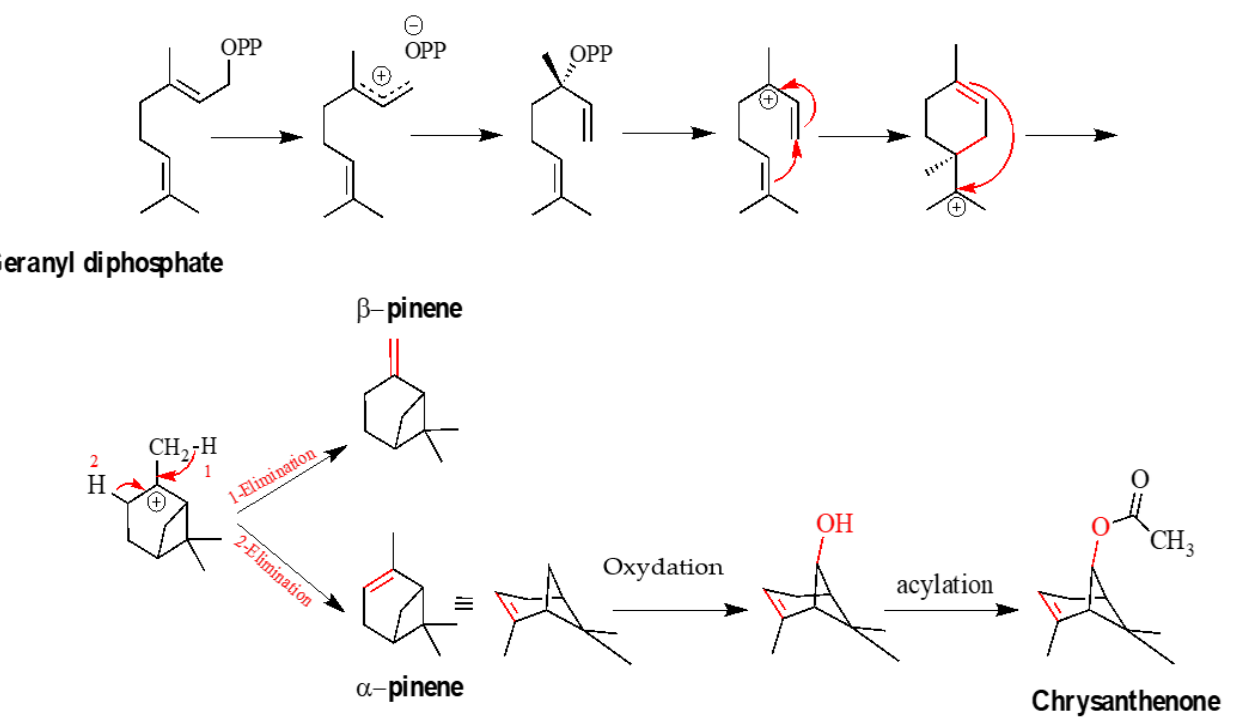
Figure 3. Hypothetic biosynthesis pathway explaining the reduction in the proportion of the pinene fraction toward an increase in chrysanthenone content.